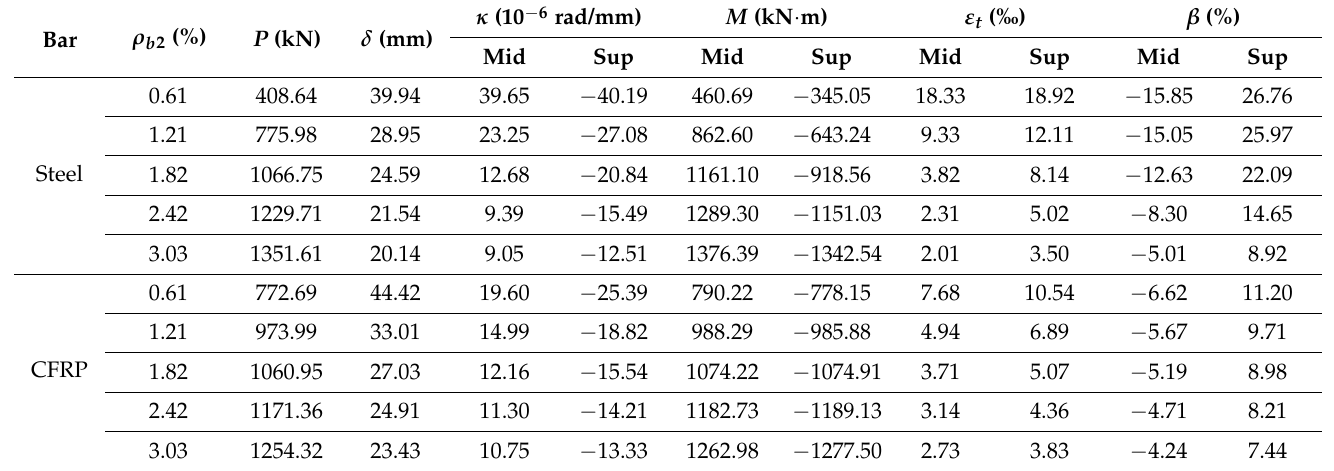
Figure 6. Variation of ultimate curvature with varying bar ratio. Table 1. Values of typical response characteristics in